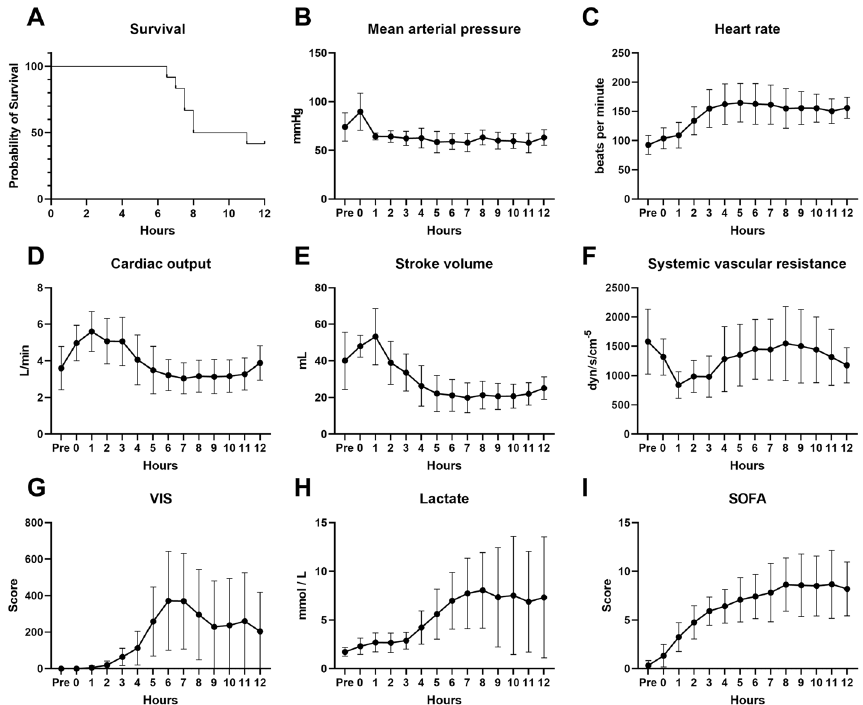
Fig. 1 Trends of survival ( A ), hemodynamic variables ( B – F ), VIS ( G ), lactate levels ( H ), and SOFA scores ( I ) of